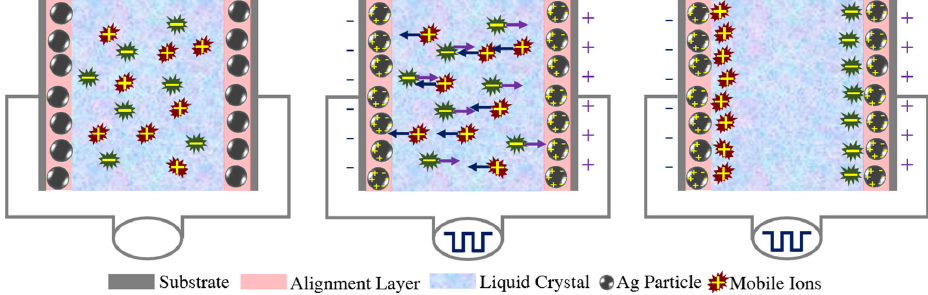
Figure 1. The schematic of mobile ions accumulating on Ag-d-PI composite alignment